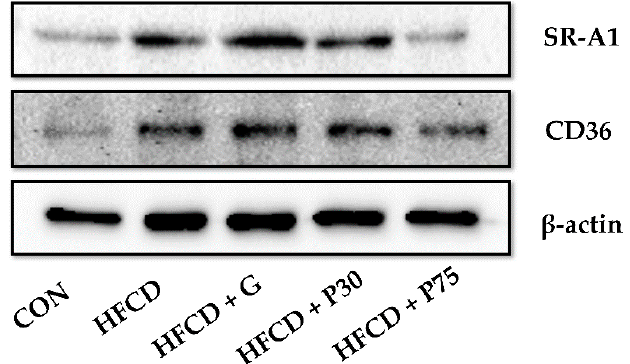
Figure 4. PEITC regulates lipid accumulation genes in the livers of HFCD-fed mice: Immunoblotting was used to measure the protein levels of scavenger receptor A (SR-A1) and cluster of di ff erentiation 36 (CD36). Equal loading of protein was ensured by stripping the immunoblot and reprobing for β -actin. CON: AIN-93G diet, HFCD: 60% calories from fat + 1% cholesterol, HFCD + G: HFCD + 3 mg / kg / day